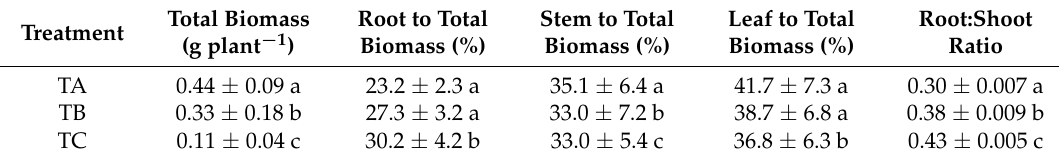
Table 2. Effect of three watering treatments (TA, well-watered (85% pot capacity (PC); TB, moderate water stress (65% PC); and TC, severe water stress (45% PC)) on the total biomass, the leaf, stem and root biomass as a percentage of the total biomass, and root-shoot ratio of lucerne seedlings. The values are means ± one standard error of the mean ( n = 3).